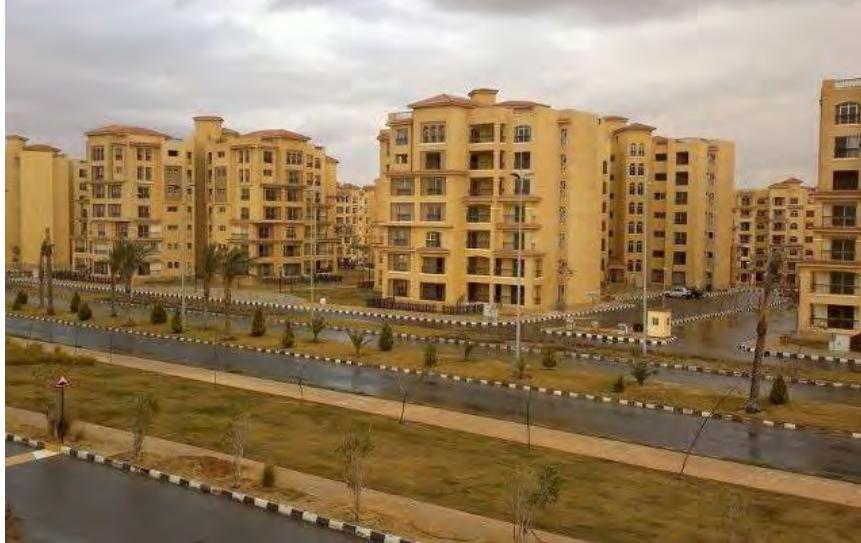
Fig.4: Madinty Streets.